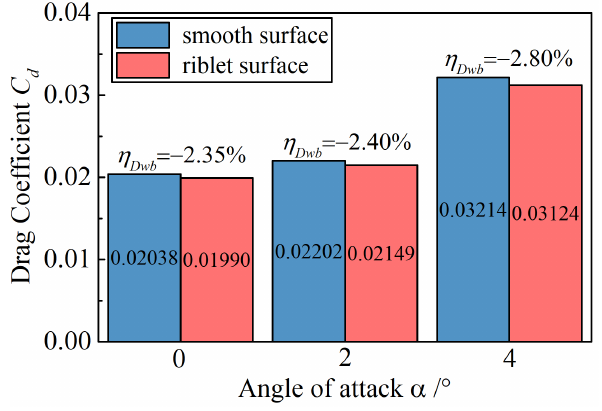
Figure 20. Experimental